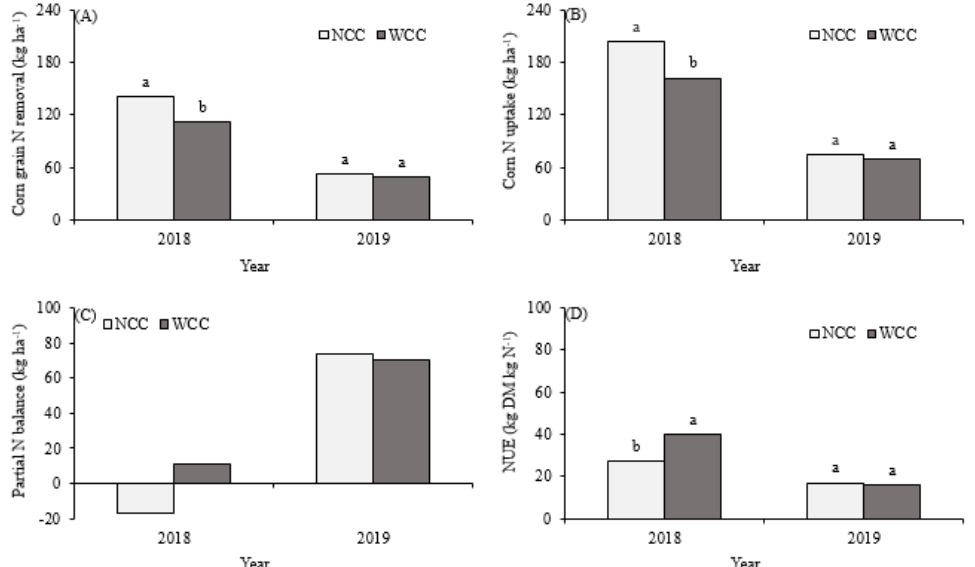
Figure 2. Corn grain nitrogen (N) removal ( A ); uptake ( B ); partial N balance ( C ); and N use efficiency ( D ) as affected by wheat cover crop (WCC) and no cover crop (NCC) treatments in 2018 and 2019 growing seasons. Different letters indicate significant difference at p ≤ 0.05.